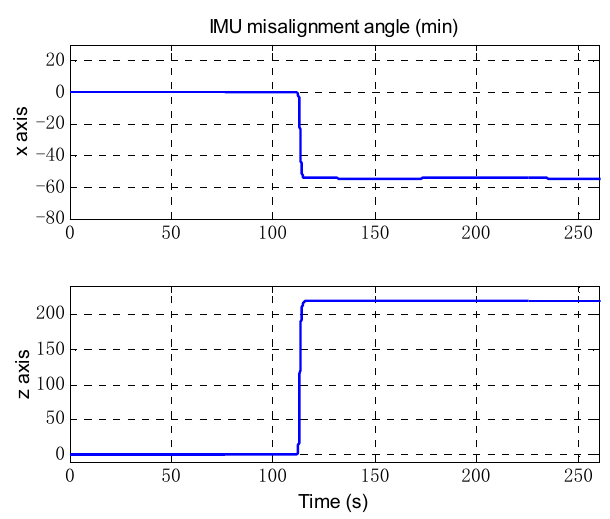
Figure 14. The estimation of IMU misalignment angle. The upper figure is the misalignment angle of x axis, and the bottom figure is the misalignment angle of z axis.